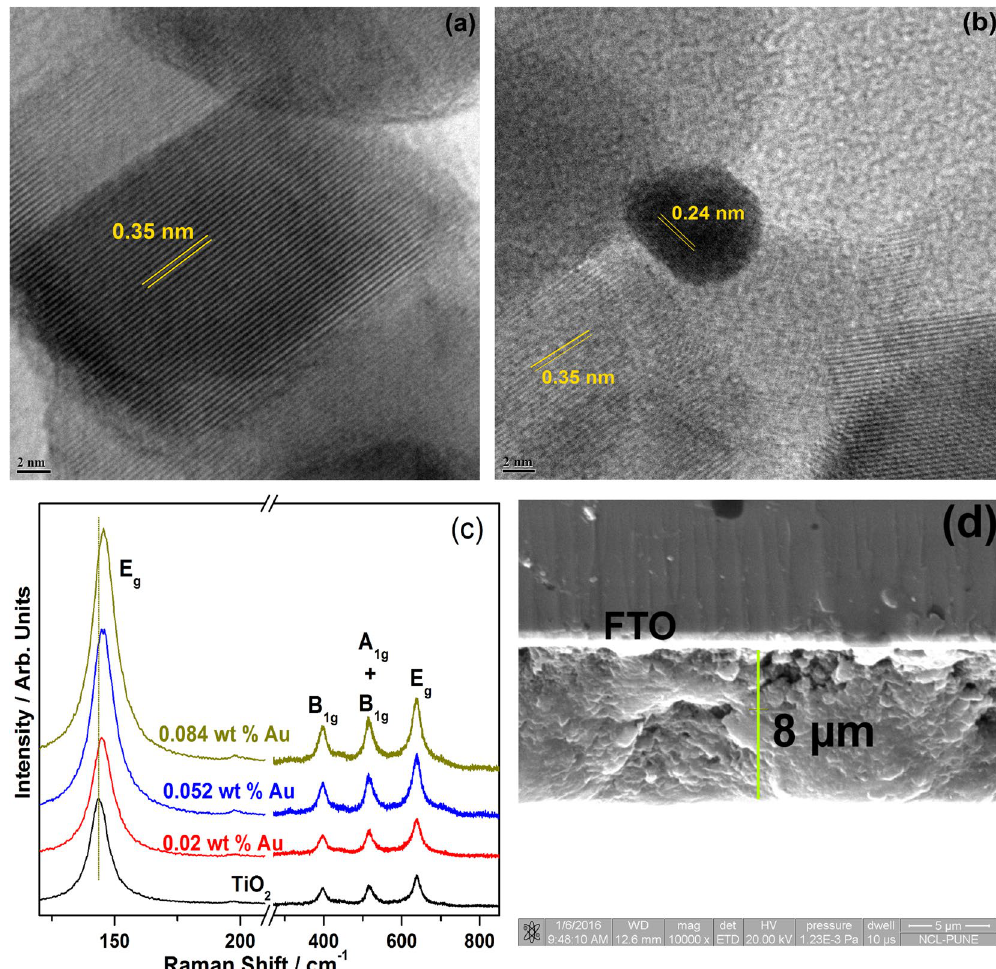
Figure 1. ( a and b ) HRTEM image of the AuTiO 2 exhibiting the heterojunction between Au and TiO 2 . TiO 2 particle exposes (101) facets predominantly. Scale bar in both images is 2 nm. ( c ) Raman spectra of pure TiO 2 and Au-TiO 2 . Enhancement in the intensity of titania features and shift in E g mode suggests the active role of PIRET process. ( d ) Representative image of freshly cleaved 8 µ m thick surface of AuTiO 2 /PbS/CdS electrode recorded by SEM. The bright thick white line is due to FTO, coated on